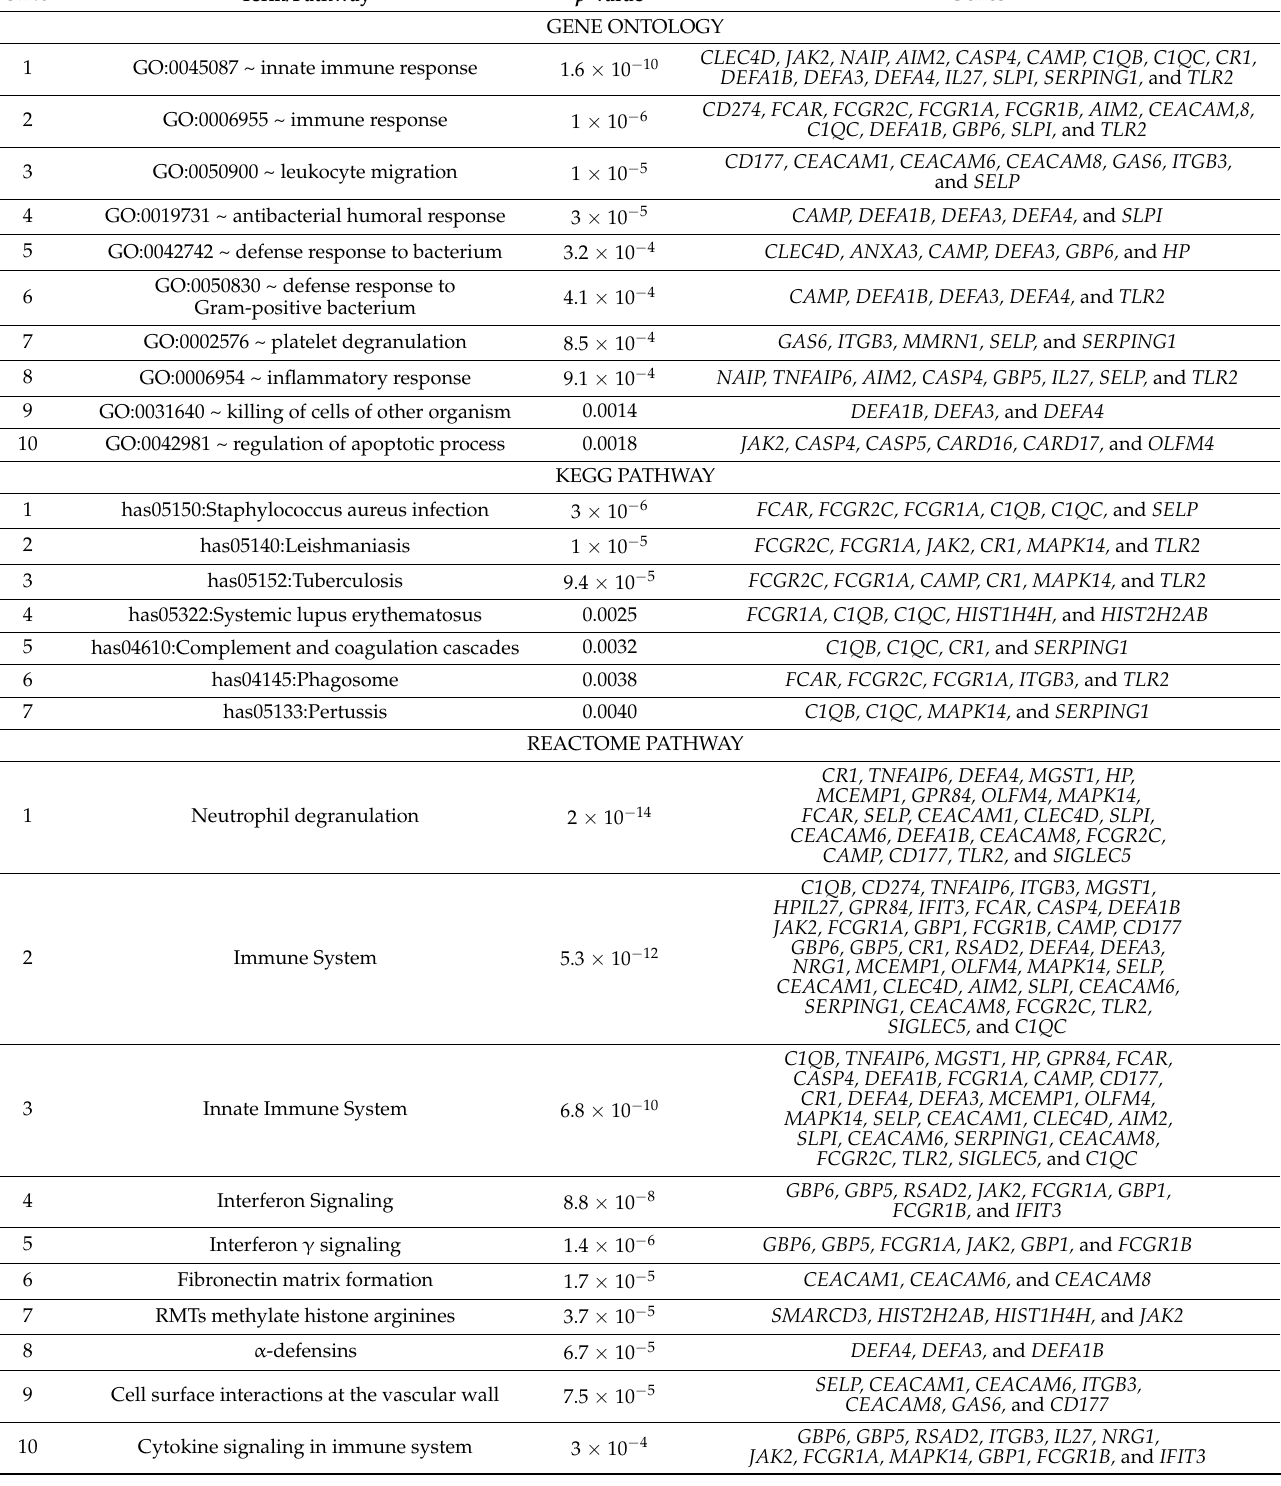
Table 2. Gene ontology and pathway enrichment analysis of upregulated